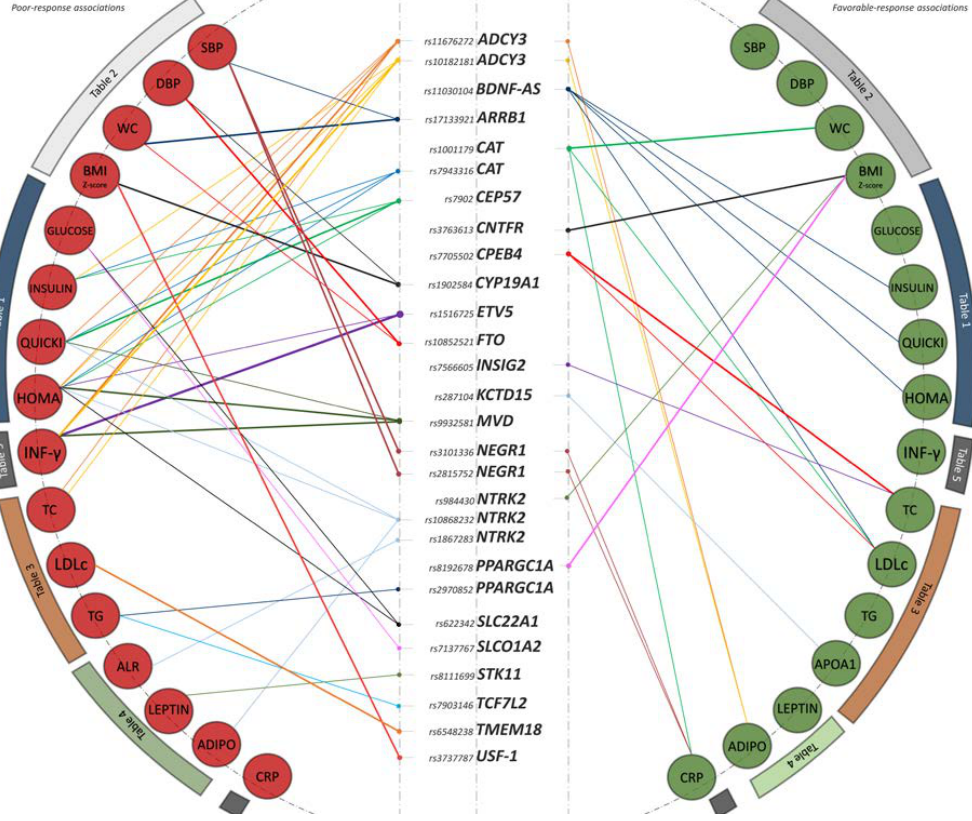
Figure 2. Interaction graph comprising all reported statistically significant associations in the discovery phase. Associations are clustered by phenotype block. The right half of the plot represents favorable-response associations, while the left half of the plot represents poor-response associations. Graph edges are weighted by the level of significance reported for each association. Abbreviations: